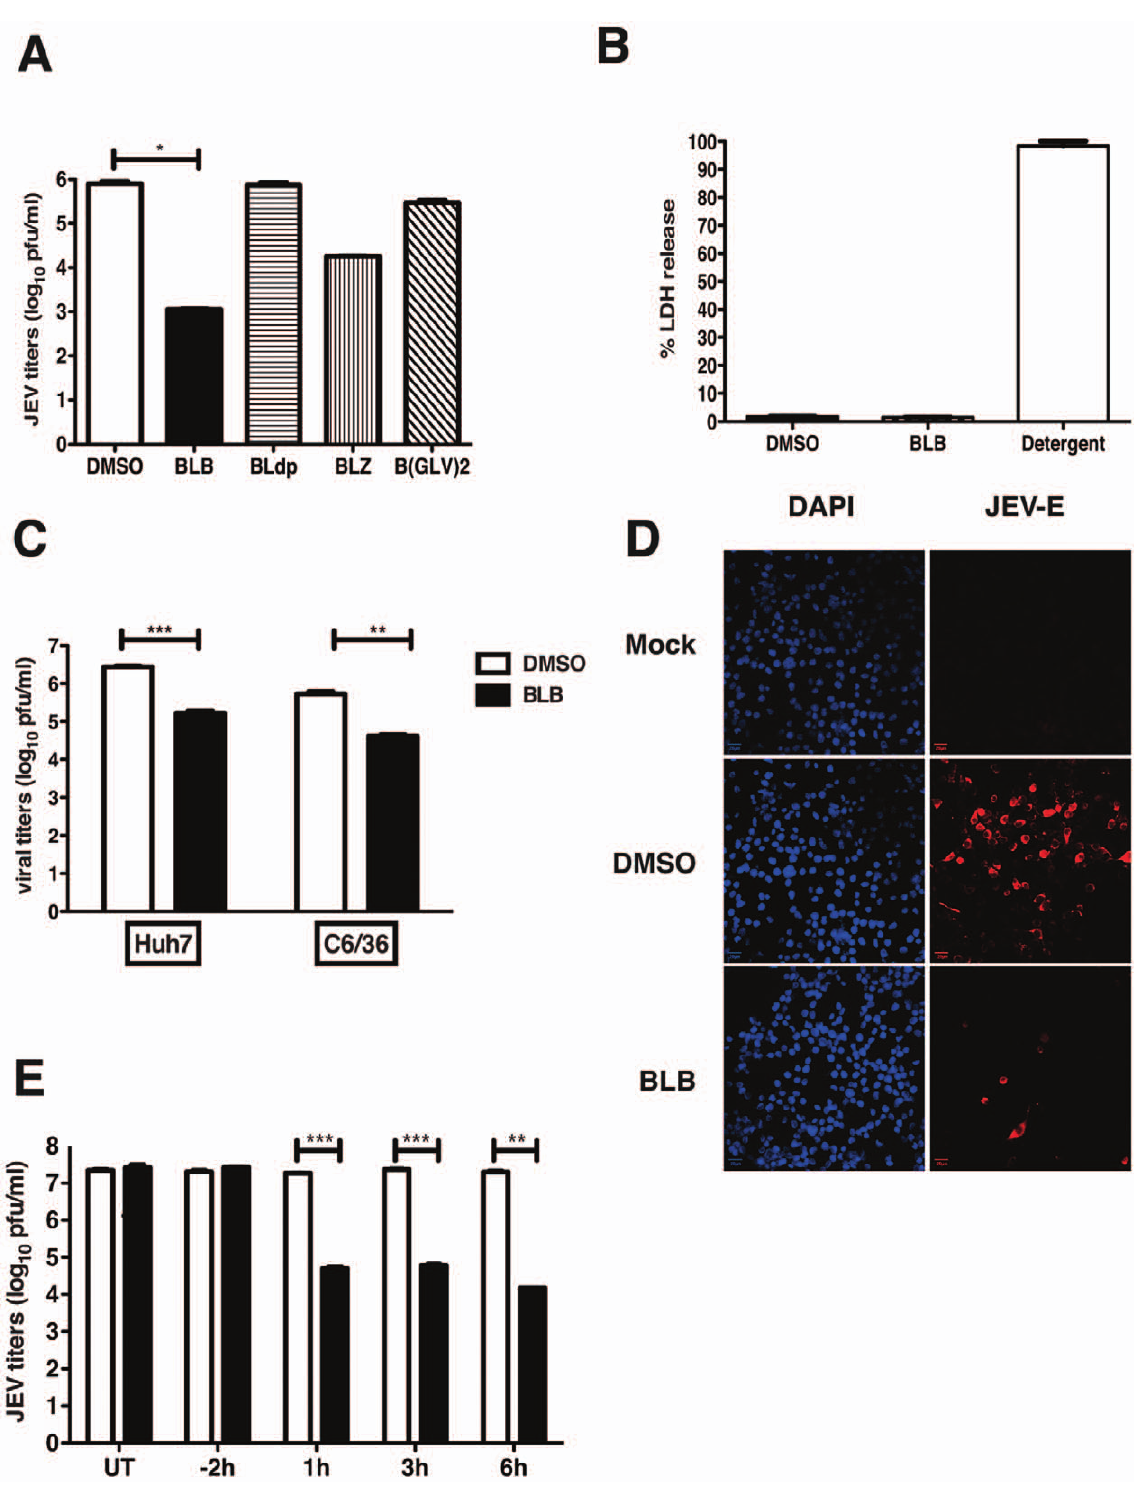
Figure 2. Effect of Bispidine derivatives on JEV infection. (A) Viral titers were determined by plaque assay of N2A cell culture supernatants (22 h pi) infected with JEV and treated with 100 m M of derivatives of bispidine. * P , 0.01 determined by two-tailed, t-test. (B) Cytotoxicity was measured by lactate dehydrogenase (LDH) assay from culture supernatants treated with 100 m M of BLB or DMSO. LDH released from cells incubated with detergent buffer was used as 100% LDH release. (C) Viral titers were determined by plaque assay from Huh7 and C6/36 cell culture supernatants (22 h pi) infected with JEV and treated with 100 m M of BLB. *** P=0.0002 and **P=0.0041 determined by two-tailed, t-test. (D) N2A cells were infected as above and at 22 h pi cells were fixed and stained with anti-E antibodies followed by alexa 568-conjugated secondary antibodies. Nuclei were stained by DAPI. (E) Viral titers were determined by plaque assay of N2A cell culture supernatants (22 h pi) infected with JEV and treated with 100 m M of BLB at the indicated time points. UT- Untreated. All the data presented are representative of two or more experiments performed with two or more replicates. *** P=0.0007, 0.0005 and **P=0.007 as determined by two-tailed, t-test. Error bars in all figures represent Mean 6 SEM. doi:10.1371/journal.pntd.0002005.g002 PLOS Neglected Tropical Diseases |